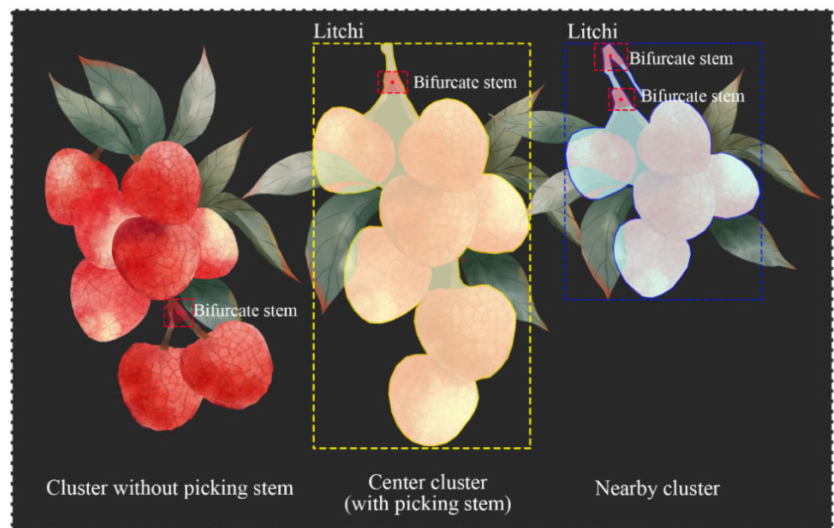
Figure 7. Picking point